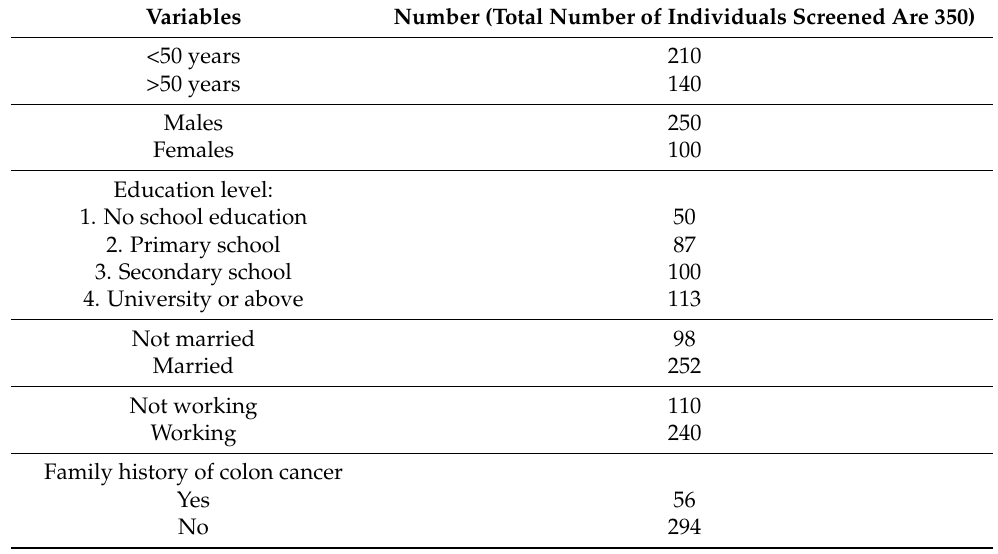
Table 1. Demographics of individuals completing the public knowledge questionnaire on